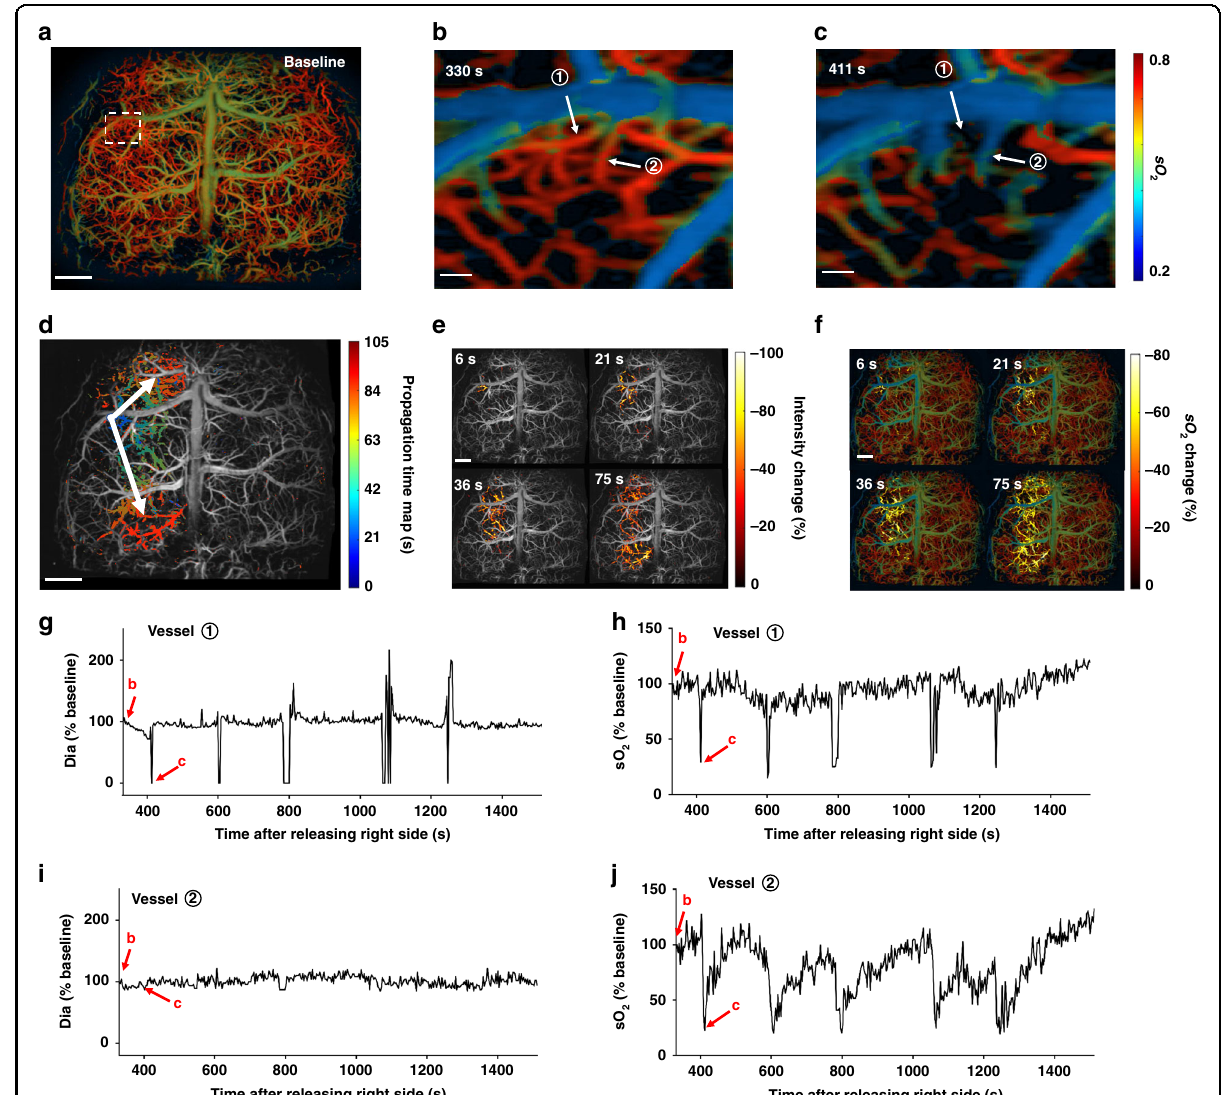
Fig. 5 UFF-PAM of the stroke-induced SD waves. a sO 2 image of the whole cortex at baseline. b , c Close-up sO 2 images of the SD wave origin at 330 s and 411 s after releasing the right carotid artery, as indicated by the white dotted rectangle in ( a ). Two representative vessels ① and ② were selected for further analysis. d Propagation time map of a representative SD wave. Arrows represent the direction of SD wave. e The change in PA signal intensity during the SD wave propagation at 6 s, 21 s, 36 s and 75 s, respectively. f The change in sO 2 during the SD wave propagation. g The diameter change of vessel ① over a SD wave. h The sO 2 change of vessel ① over a SD wave. i The diameter change of vessel ② . j The sO 2 change of vessel ② . Scale bars, 1 mm for ( a , d , e , f ), 100 μ m for ( b , c